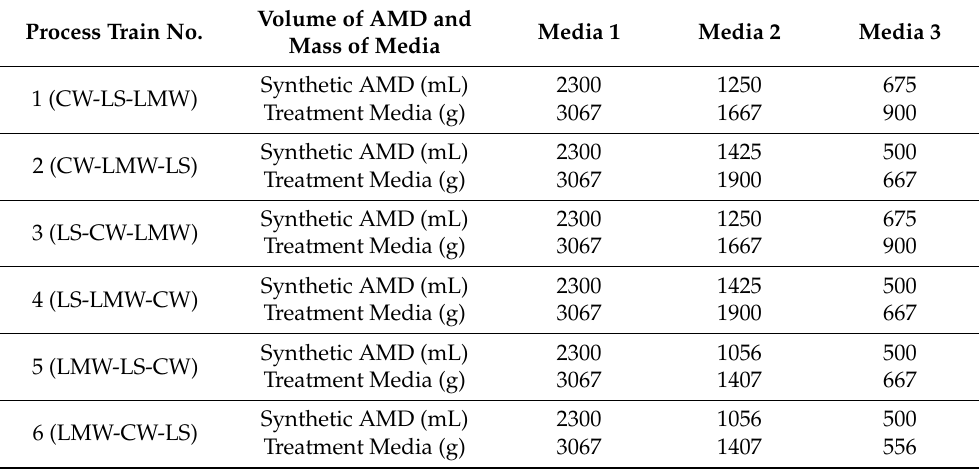
Table 4. Volume of AMD and weight of media per